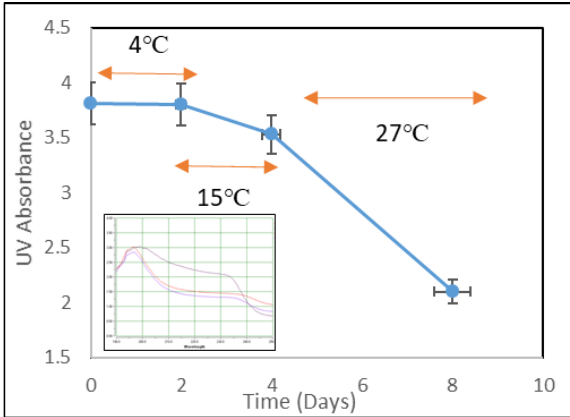
Figure 6: Temperature effect on hydrolysis rate in soil sample